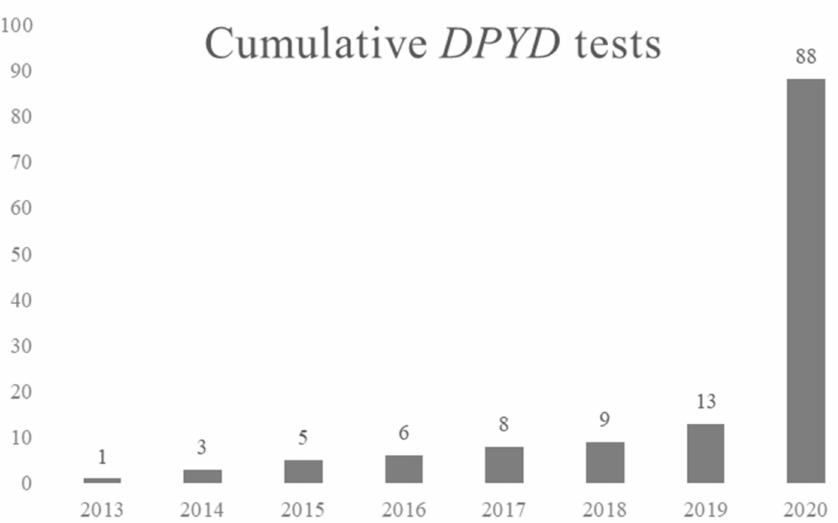
Figure 1. Cumulative DPYD genotyping tests performed at the Pharmacogenetics Unit, Hospital Universitario de La